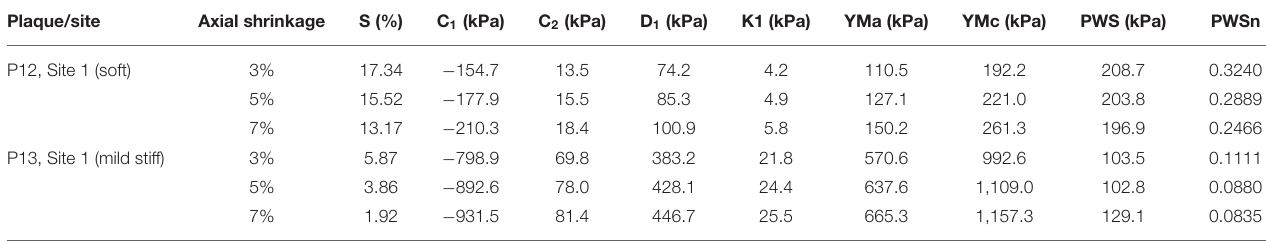
TABLE 4 | Impact of axial shrinkage on circumferential shrinkage (S), YM, and PWS/PWSn of three representative slices.